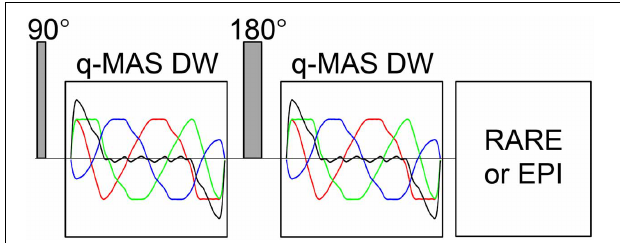
FIGURE 4 | Schematic of the diffusion MRI pulse sequence with isotropic or directional diffusion weighting. The 90 and 180 ◦ RF pulses produce a spin echo, which is acquired with a single-shot RARE sequence at the high field spectrometer or EPI sequence at the clinical scanner. Identical DW blocks are inserted on each side of the 180 ◦ pulse. Isotropic DW is achieved with a numerically optimized q -MAS gradient modulation scheme [37] as shown with the green ( G x ), blue ( G y ), and red ( G z ) lines. The black line indicates the directional gradient waveform that yields the same magnitude of dephasing [34] as the q -MAS